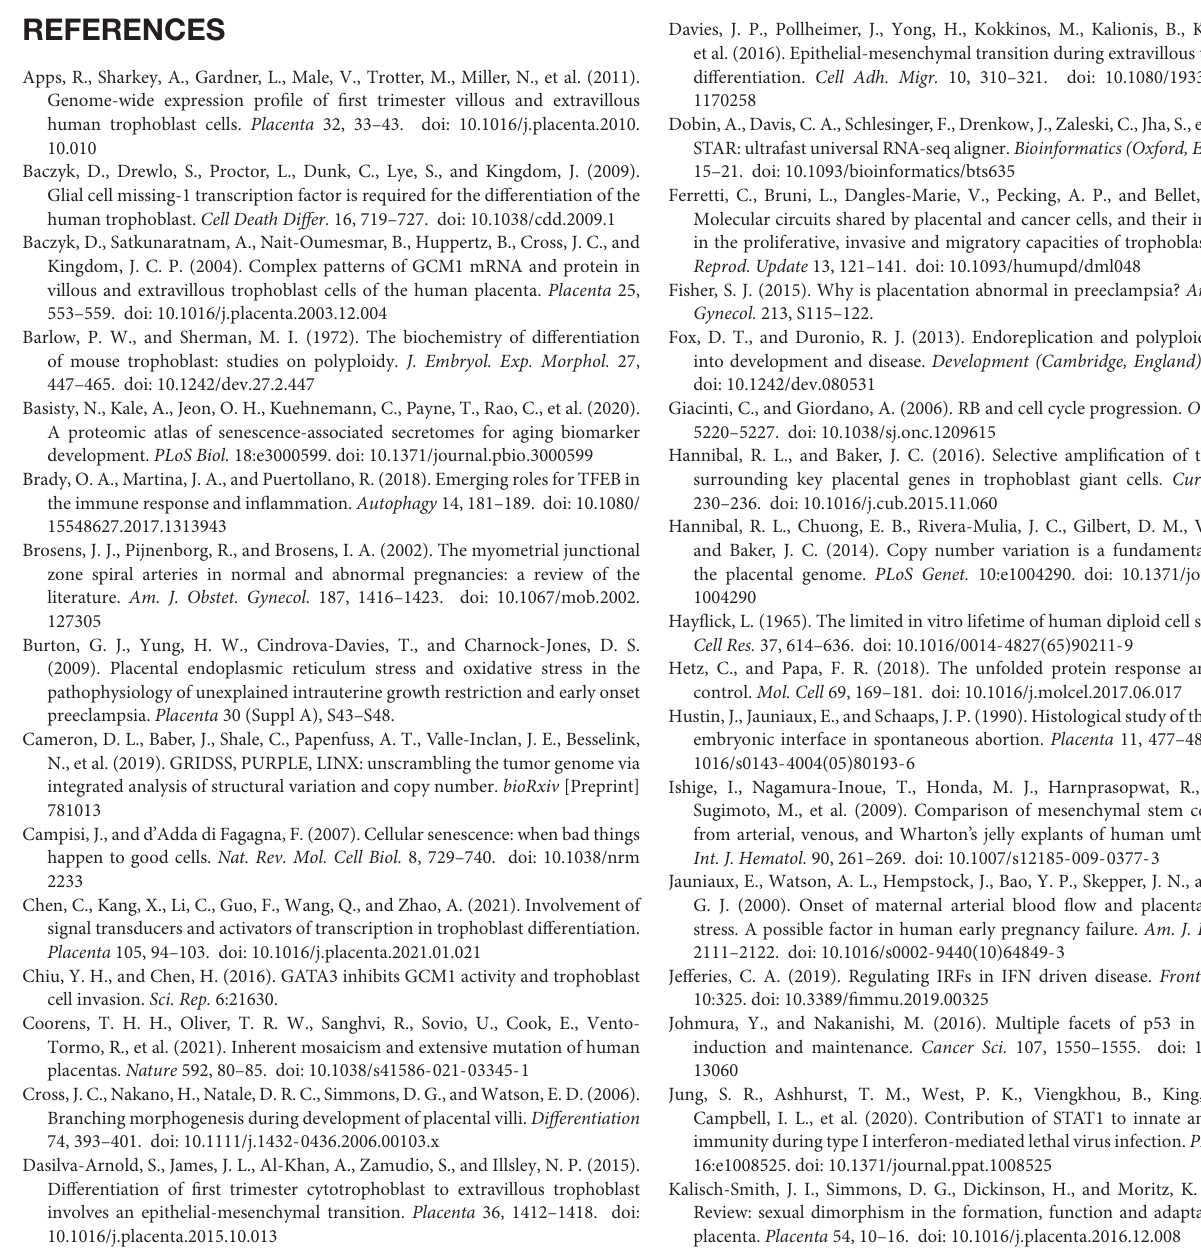
Supplementary Figure 6 | Expression of cell cycle-associated genes in first trimester and term CTB and EVT. (A) Normalized gene expression in all samples for AURKA, CDK1, MKI67, and CCNB1. (B) Cell cycle scoring based on previously-identified cell cycle phase-specific gene expression (Macosko et al., 2015) on term single-cell RNA-seq data (Tsang et al., 2017) visualized in a UMAP representation. HLAG and EGFR expression are shown to identify EVT and CTB cell clusters, respectively. (C) Cell cycle and endoreduplication-associated gene expression (normalized counts) of Cyclin E1 (CCNE1). Supplementary Table 1 | Details of all samples used in study. CTB, cytotrophoblast; EVT, extravillous trophoblast; MSC, umbilical cord-derived